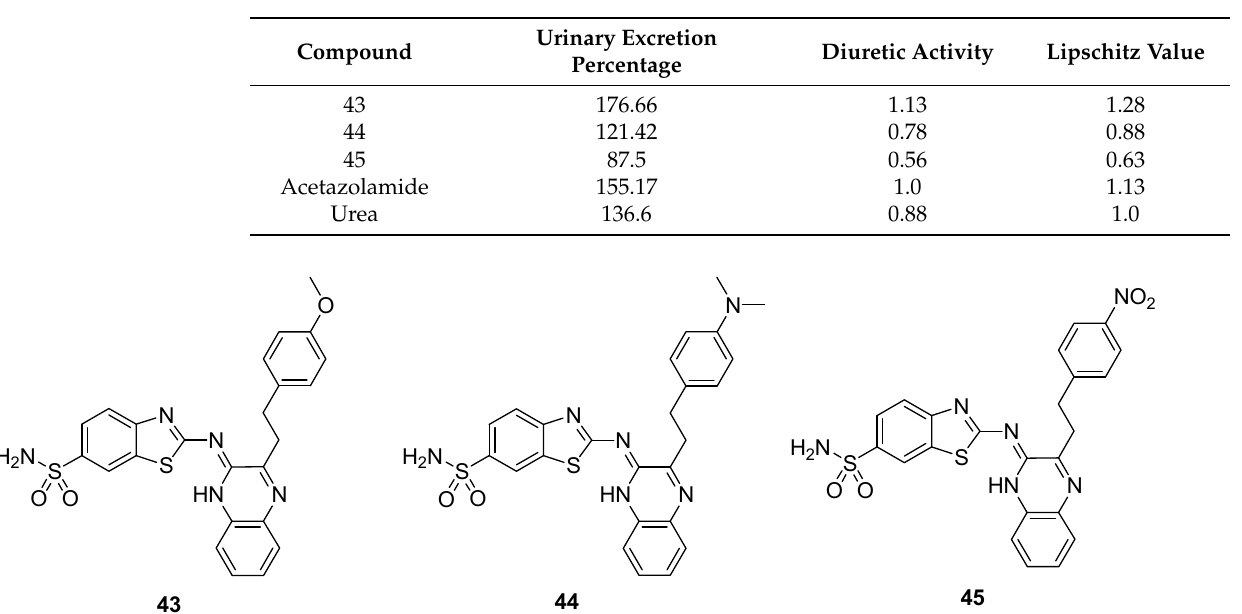
Scheme 1. Synthesis of sulfonamide derivatives 42 . Table 1. Diuretic activity of benzothiazole quinoxaline sulfonamide derivatives 43 – 45 .